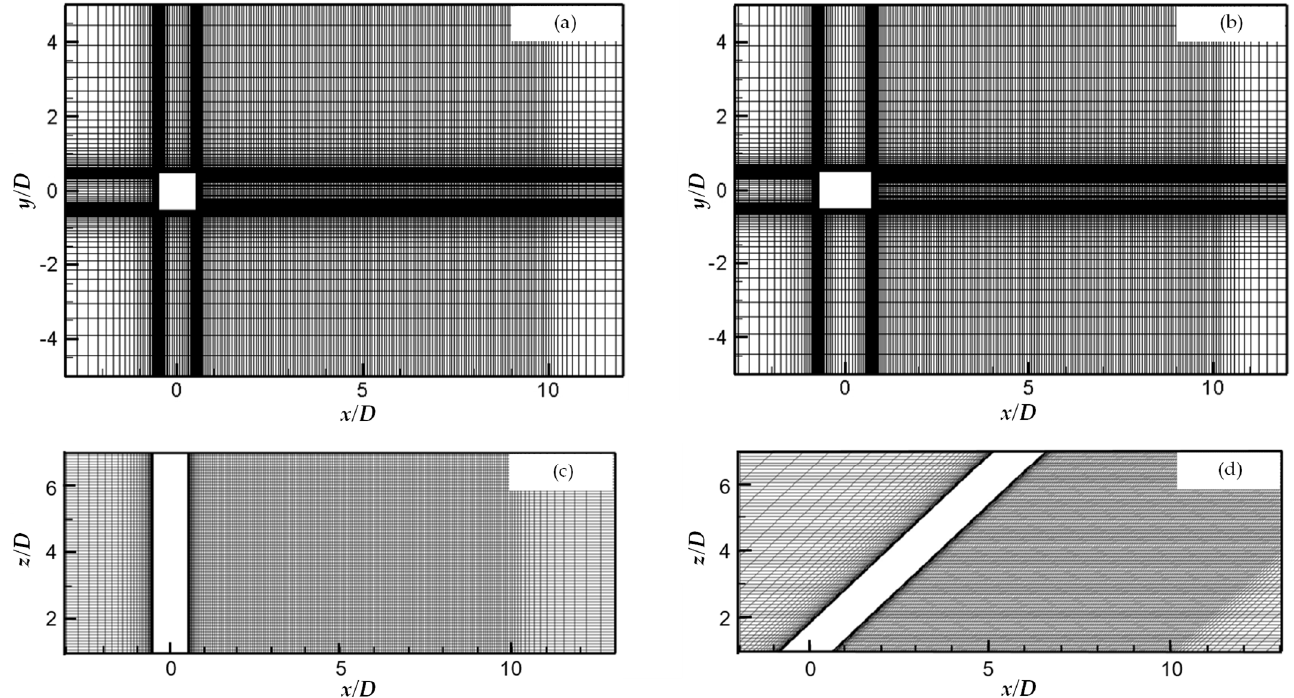
Figure 2. A close-up view of the mesh. Top view on plane z = 0: ( a ) α = 0°; ( b ) α = 45°. Side view on plane y = 0: ( c ) α = 0°; ( d ) α = 45°.